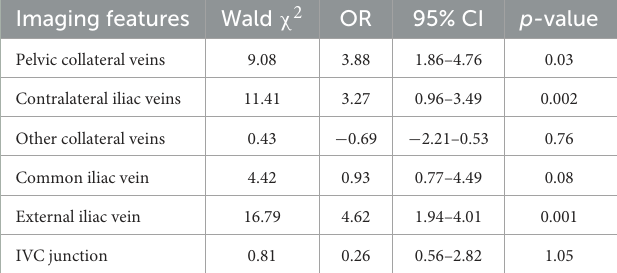
TABLE 4 Multiclassification logistic regression analysis of 3D-RV iliac vein stenosis imaging